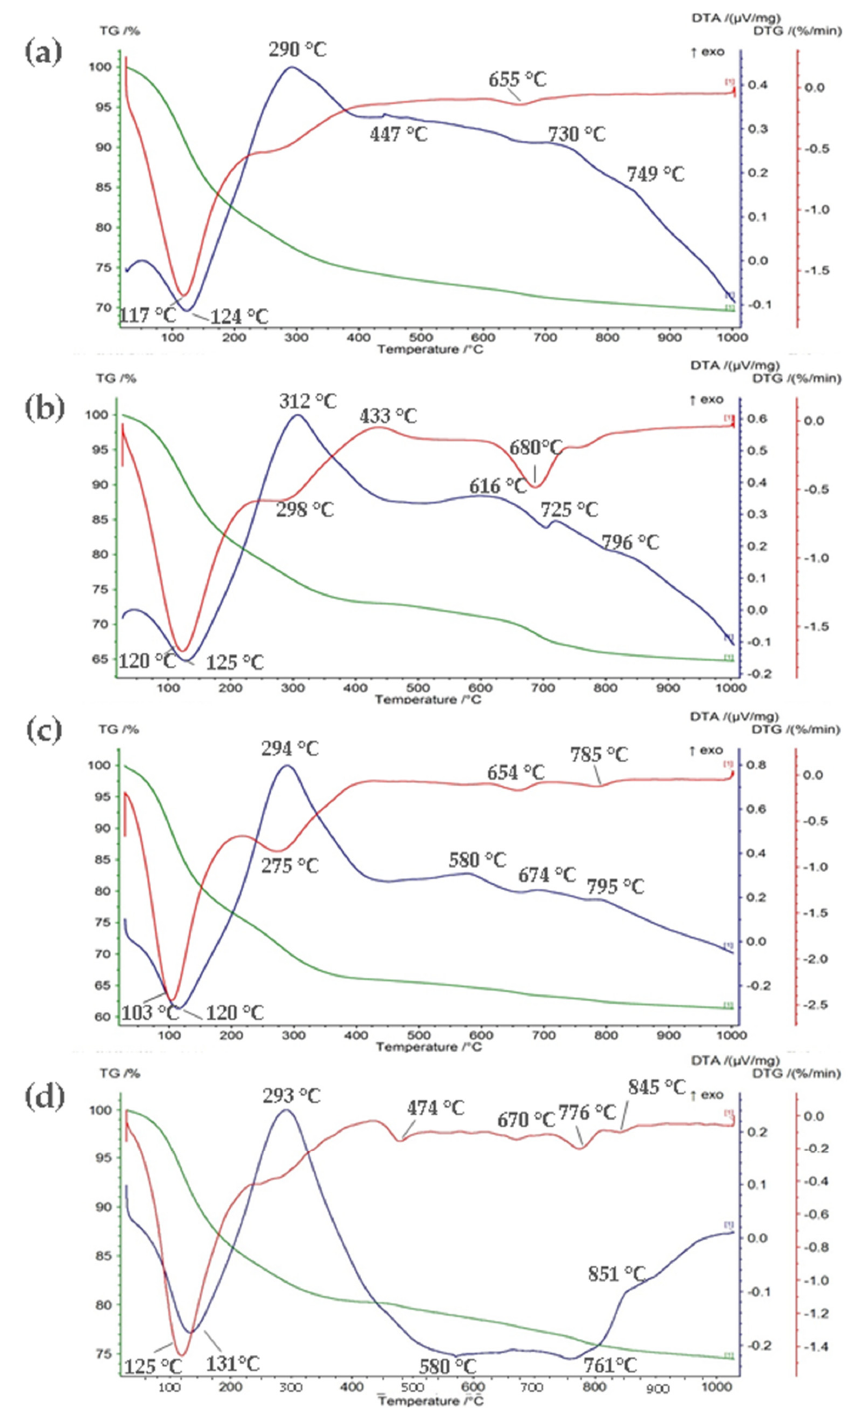
Figure 3. TG, DTG, and DTA analysis of: ( a ) GWTRa-1, ( b ) GWTR-2, ( c ) GWTR-3, ( d ) GWTR-4. The color of the curve corresponds to the color of the Y scale. TG—thermogravimetric, DTG—differential thermogravimetric, DTA—differential thermal analysis.